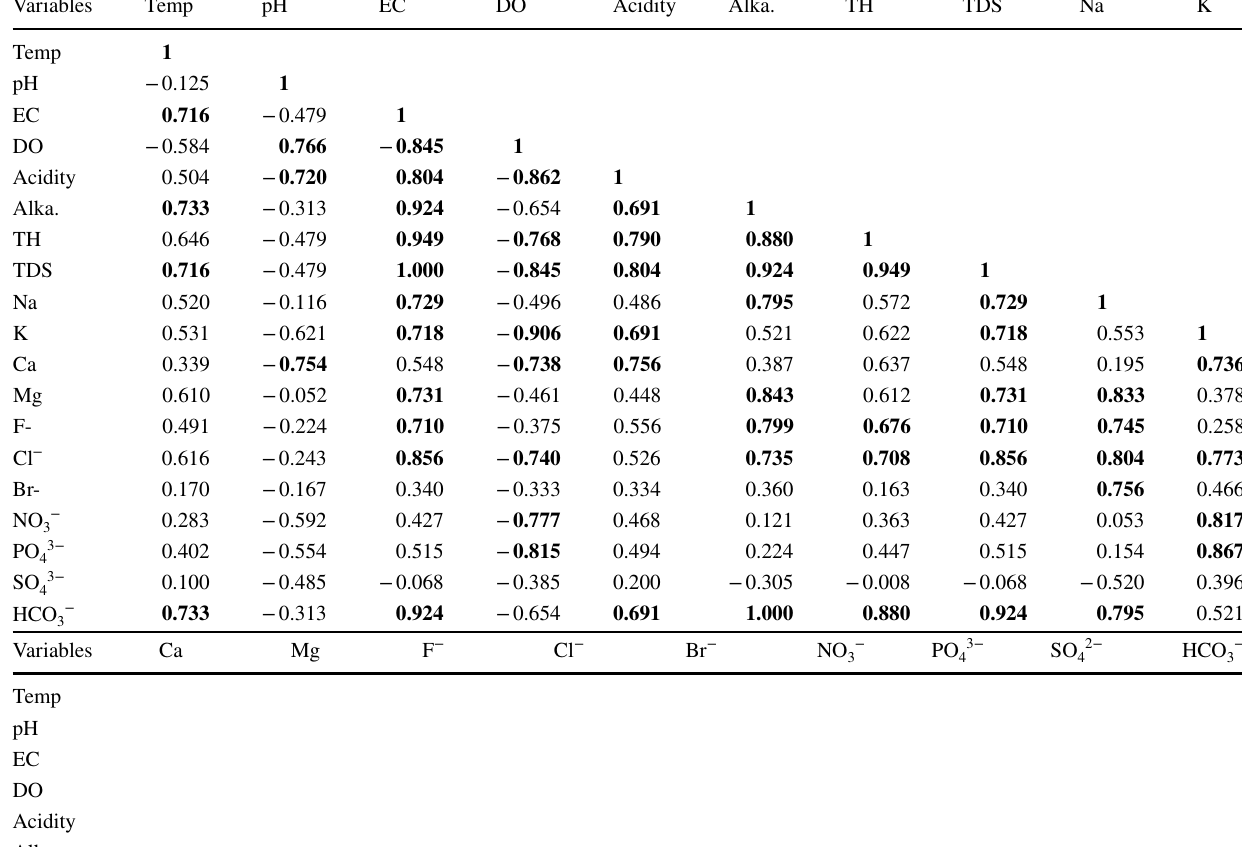
Table 2 Pearson correlation matrix of pre-monsoon water parameters